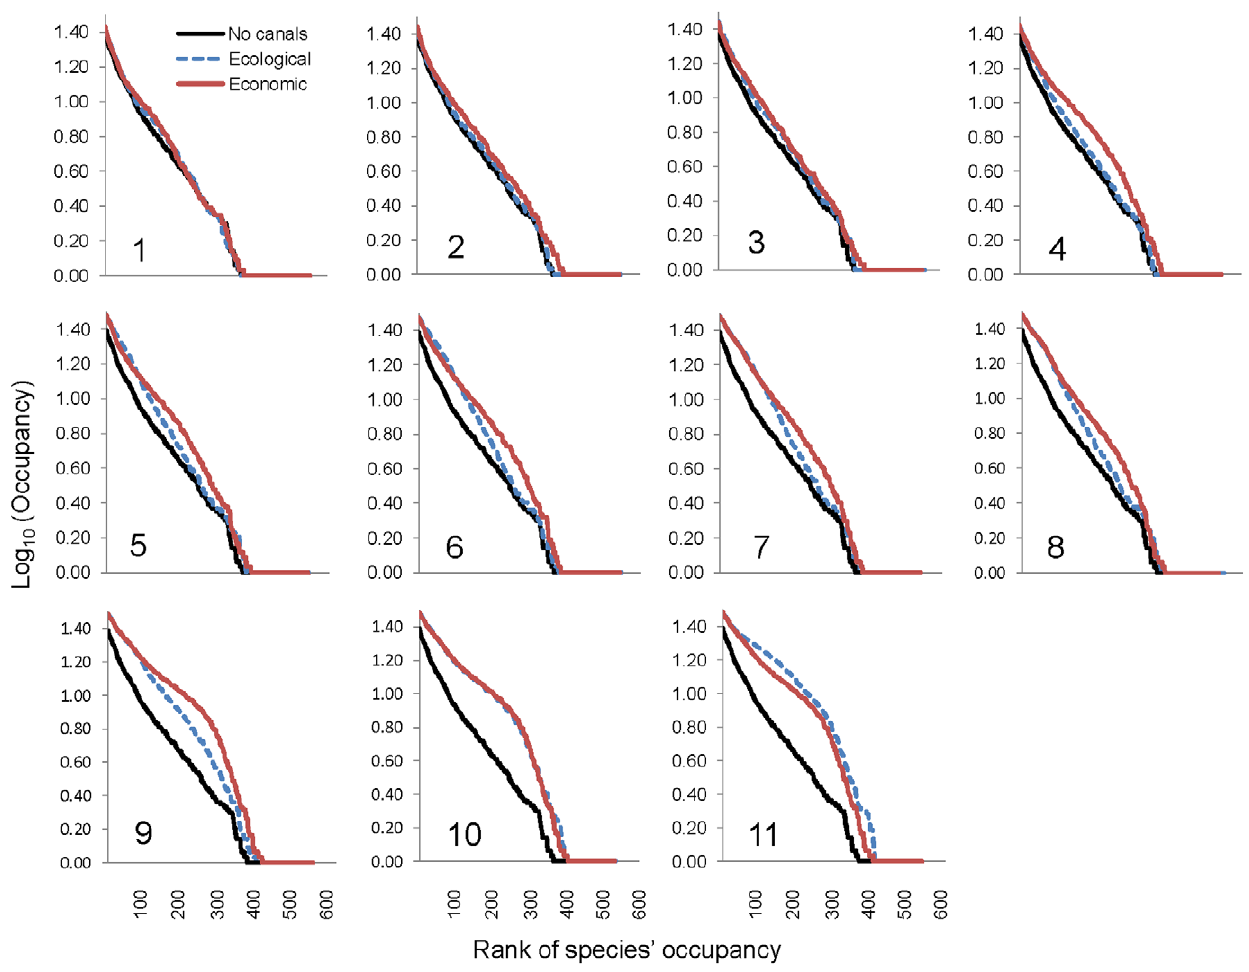
Figure 5. Average rank (of 130 generations) versus occupancy after each canal link is implemented. Note log scale of the y axis. Each of the 11 linking steps is represented by one plot. The lower, black line is the rank-occupancy under the no linking step; the solid red line is the resulting occupancy after each link is added under the ‘economic’ linking strategy, and the blue dotted line is the resulting occupancy after each link is added under the ‘ecological’ linking strategy. Each panel is an implementation step, where the canal added under the ecological strategy at a given step is not the same as the canal added in the economic strategy (compare canal implementation in Fig. 3).